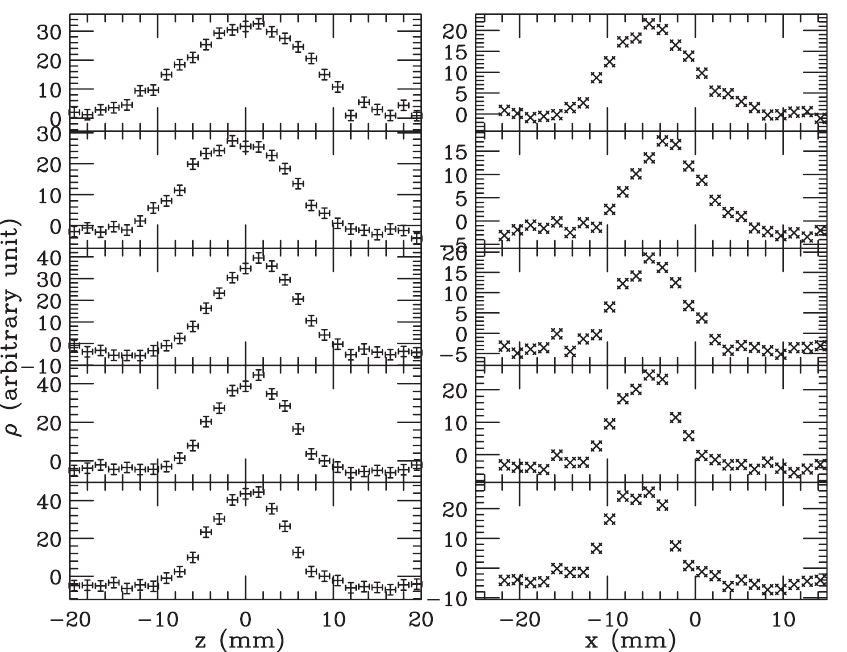
FIG. 3. The measured vertical and horizontal beam profiles for 6-turn injection measured at revolutions 500, 4000, 8000, 12 000, and 16 000 are displayed from top to bottom, respectively.